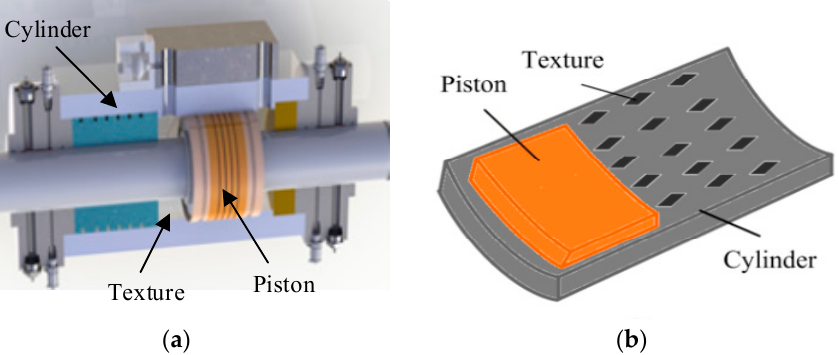
Figure 10. The hydraulic cylinder with diamond-like microtextures: ( a ) structure of hydraulic cylinder; ( b ) schematic diagram of a partially microtextured hydraulic cylinder .